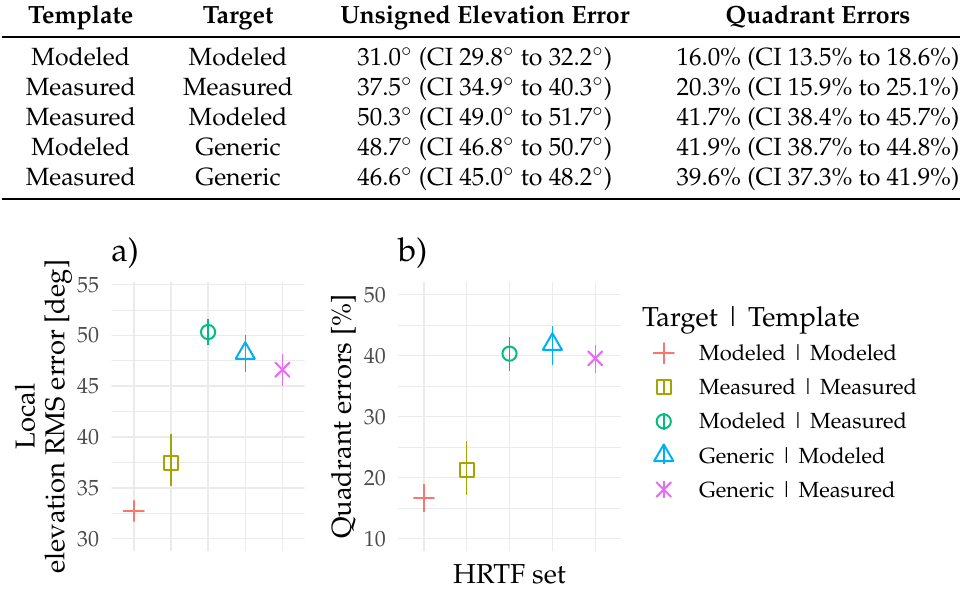
Figure 2. Auditory-model-based predictions of the ( a ) local ( θ ≤ 90 ◦ ) elevation RMS error and ( b ) quadrant errors ( θ > 90 ◦ ). The error bars denote the bootstrapped 95% confidence intervals of the mean. The applied model is the Baumgartner et al.